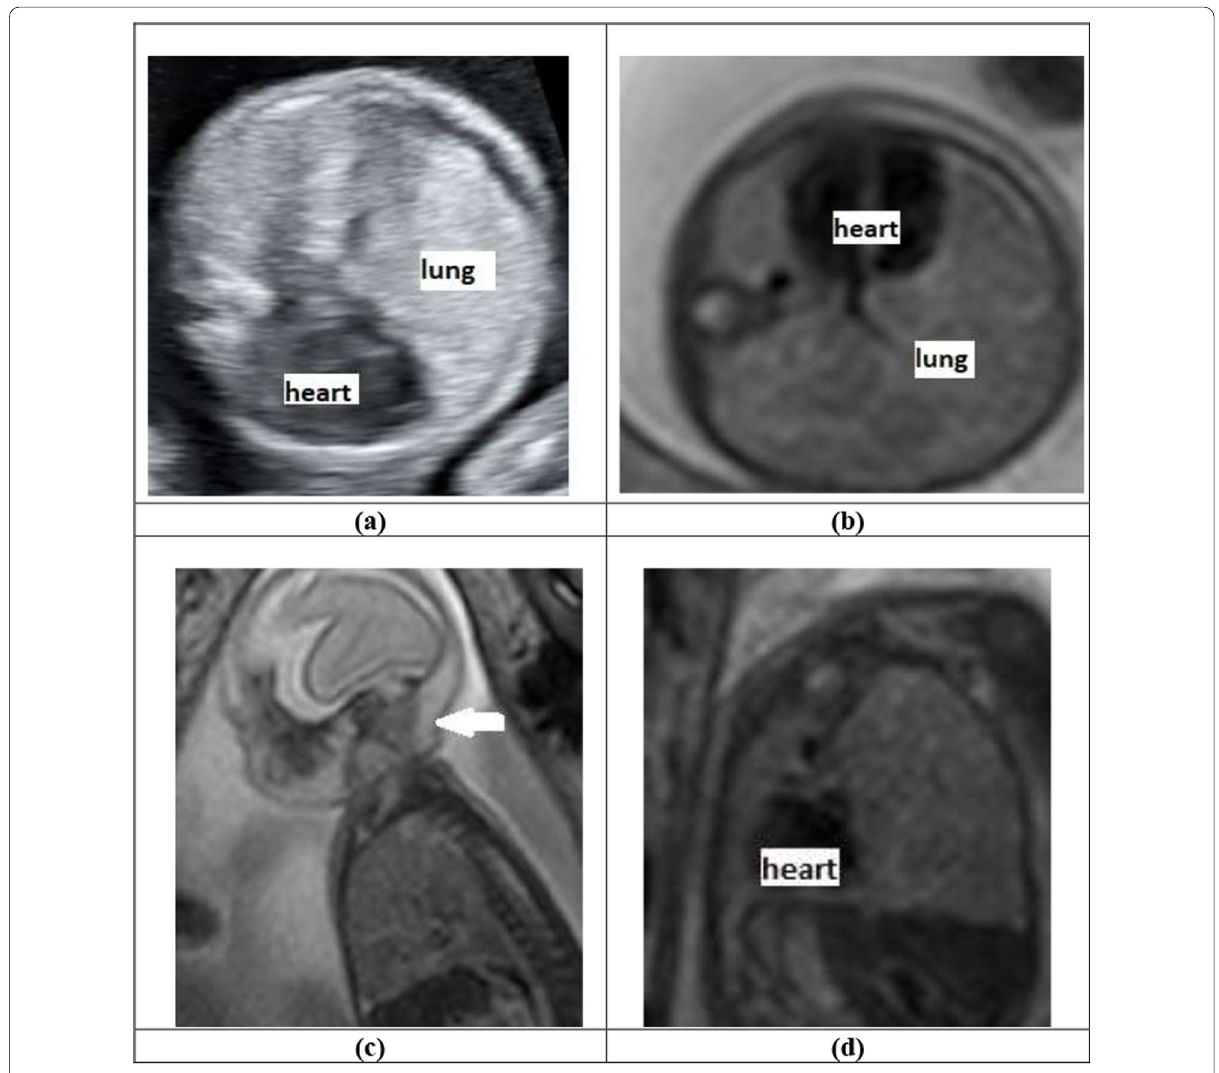
Fig. 5 25-year-old pregnant female at 27 weeks of gestation presenting with polyhydramnios. Prenatal ultrasound: a revealed polyhydramnios associated with enlarged echogenic lung …? CCAM. Prenatal fetal MRI sequences revealed polyhydramnios and hyperinflated lung with stretched vessels with marked mediastinal shift (heart) to contralateral side and compressed contralateral lung with no evidence of cystic lesion associated with increase nuchal fold (white arrow) and flattening of the diaphragm …features of congenital lung lobar emphysema (overinflation). b Axial